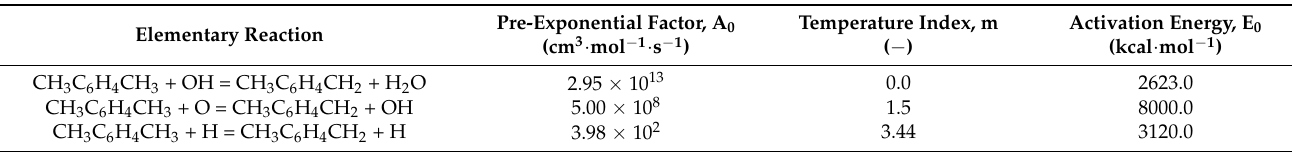
Table A5. Elementary reactions and chemical reaction kinetic parameters related to the CH 3 C 6 H 4 CH 3